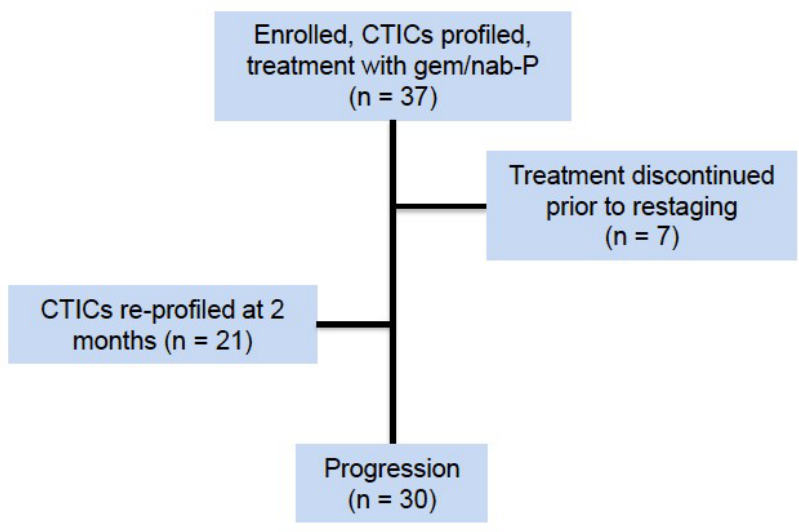
Figure 4. Consort diagram.